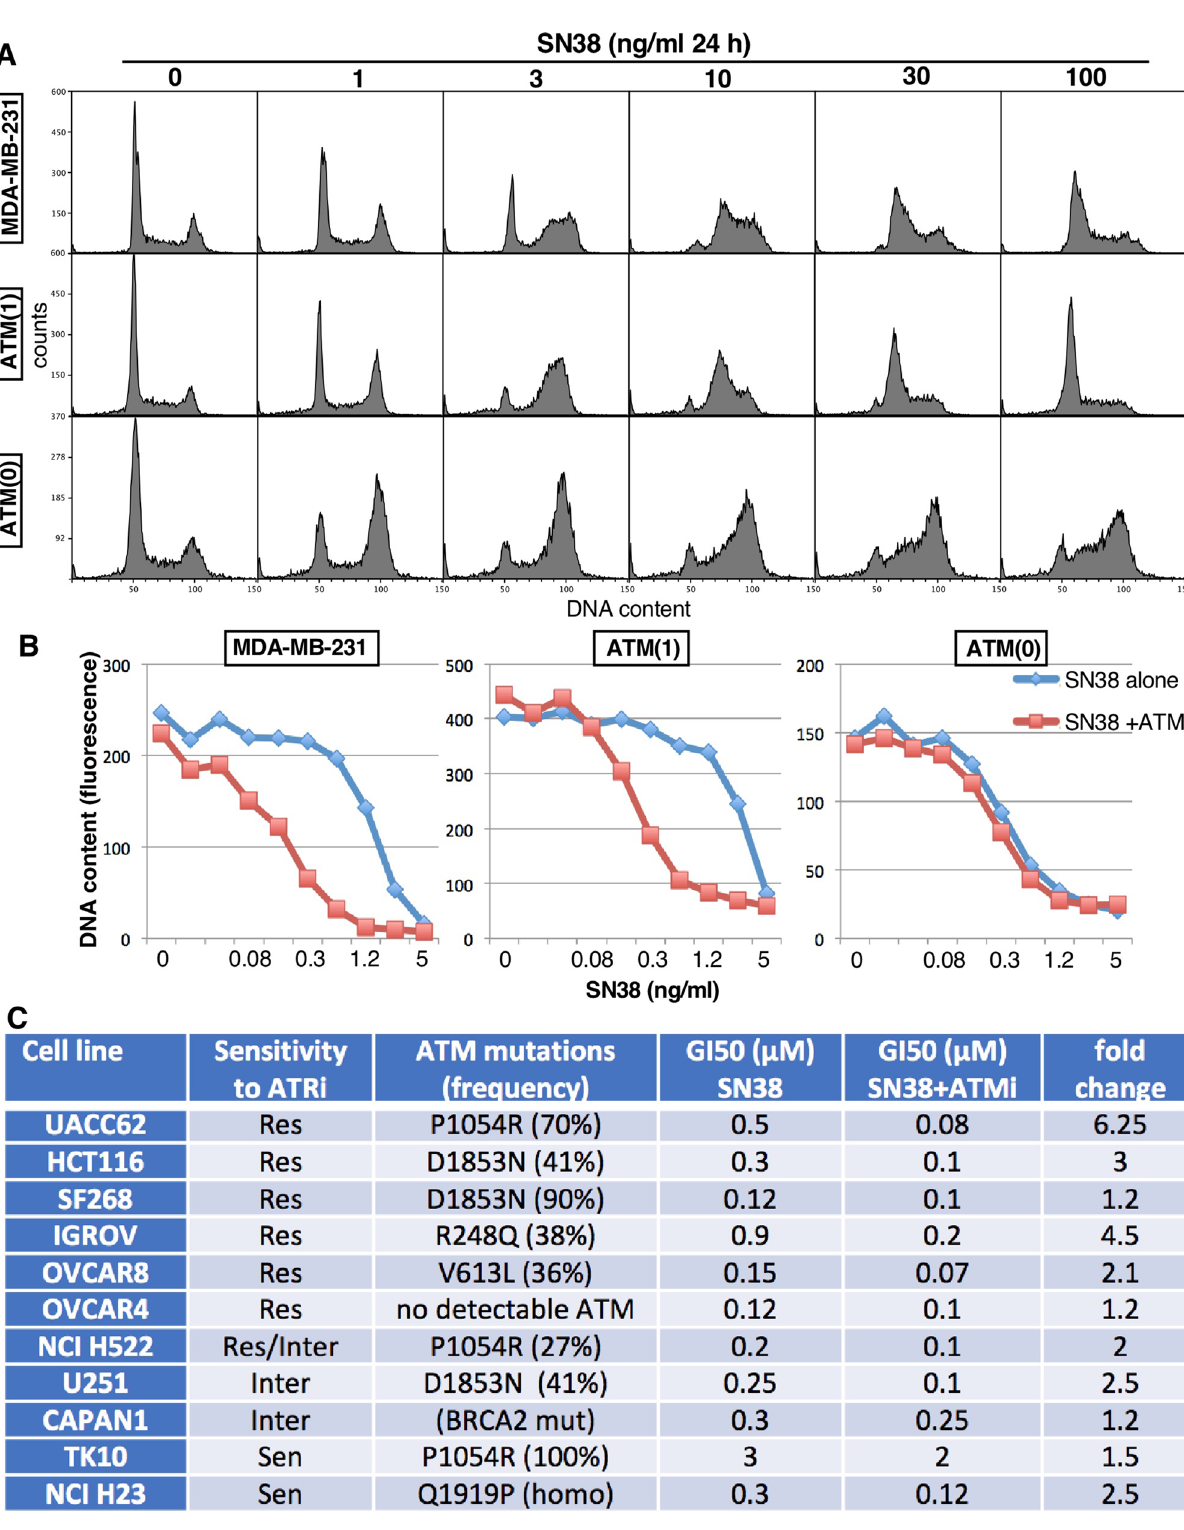
Figure 5. Impact of partial or complete ATM loss on S-phase arrest and sensitivity to combined SN38 and ATMi. ( A ) MDA-MB-231 wild-type, ATM(1), and ATM(0) cells were incubated with the indicated concentrations of SN38 for 24 h, then fixed and analyzed by flow cytometry for DNA content. ( B ) Cells were incubated with the 0–5 µM SN38 with or without 1 µM KU60019 (ATMi) for 24 h, drugs were removed and cells grown for an additional 6 days. Cells were fixed, DNA quantified and graphed versus SN38 concentration for each cell line. ( C ) Each cell line was incubated with SN38 with or without and ATMi as in B, and the GI50 concentrations